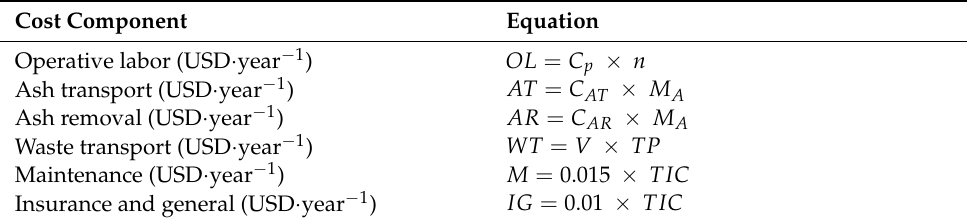
Table 3. Components of total operational